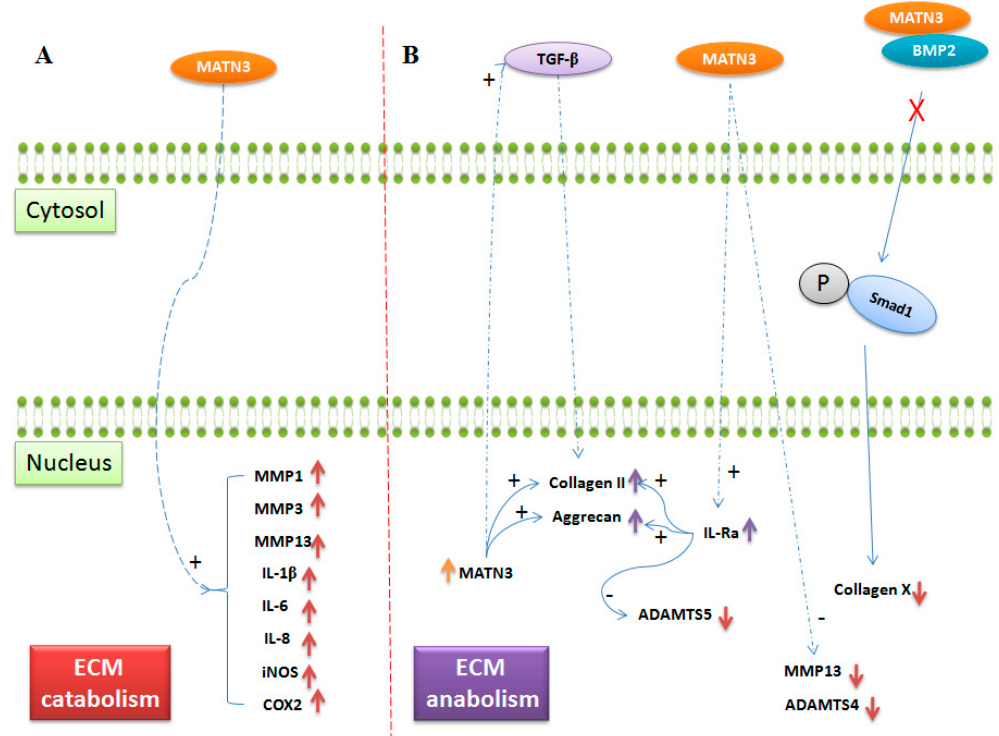
Figure 2. The schematic diagram illustrates the role of matrilin-3 in ECM modulation of cartilage. ( A ) ECM catabolism: Matrilin-3 at supra-physiological concentrations (~5 to 50 µ g/mL) increases MMP1, MMP3, MMP13, IL-1 β , IL-6, IL-8, iNOS, and COX2 expression in chondrocytes (red upward arrows); ( B ) ECM anabolism and hypertrophy: Matrilin-3 mediates the TGF- β signaling pathway. The overexpression of matrilin-3 (orange upward arrow) increases collagen II and aggrecan expression. Matrilin-3 at low concentrations (~100 to 200 ng/mL) increases IL-Ra expression, which increases collagen II and aggrecan expression (purple upward arrows), and reduces ADAMTS5. Recombinant matrilin-3 reduces ADAMTS4 and MMP13 expression (red downward arrows). Matrilin-3 binds to BMP2, thereby inhibiting BMP downstream signaling, collagen X expression, and chondrocyte hypertrophic differentiation (red cross in B ). Abbreviations: ECM, extracellular matrix; MMP, matrix metalloproteinase; IL, interleukin; iNOS, induced nitric oxide synthase; COX2, cyclooxygenase; TGF- β , transforming growth factor β ; IL-Ra, Interleukin receptor antagonist; ADAMTS, a disintegrin and metalloproteinase with thrombospondin motifs; BMP, bone morphogenetic protein. Dashed arrows (blue), unidentified signaling pathways; solid arrow (blue), identified signaling pathway; (+), positive regulatory effect; ( − ), negative regulatory effect.